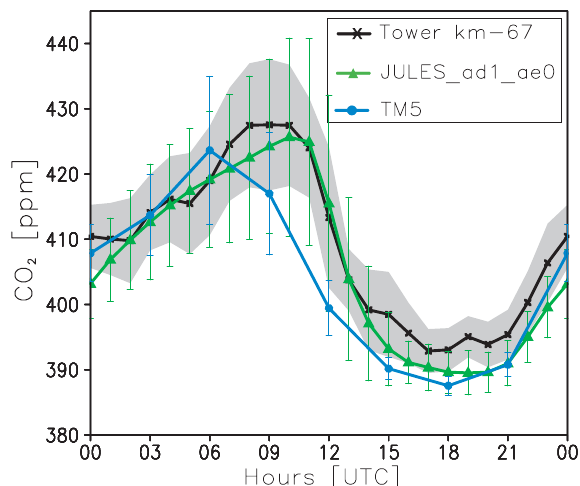
Fig. 10. Mean CO 2 concentration diurnal cycle for the month of March 2010. The black line corresponds to the observed values at the km 67 tower (Tapaj´os forest: 55.04 ◦ W, 2.85 ◦ S) at an altitude of 57.9m; the green line corresponds to the JULES-CCATT-BRAMS experiment with monotonic advection; and the blue line refers to the CarbonTracker experiment, both bilinearly interpolated to the tower location and an altitude of 39.2m (first model sigma